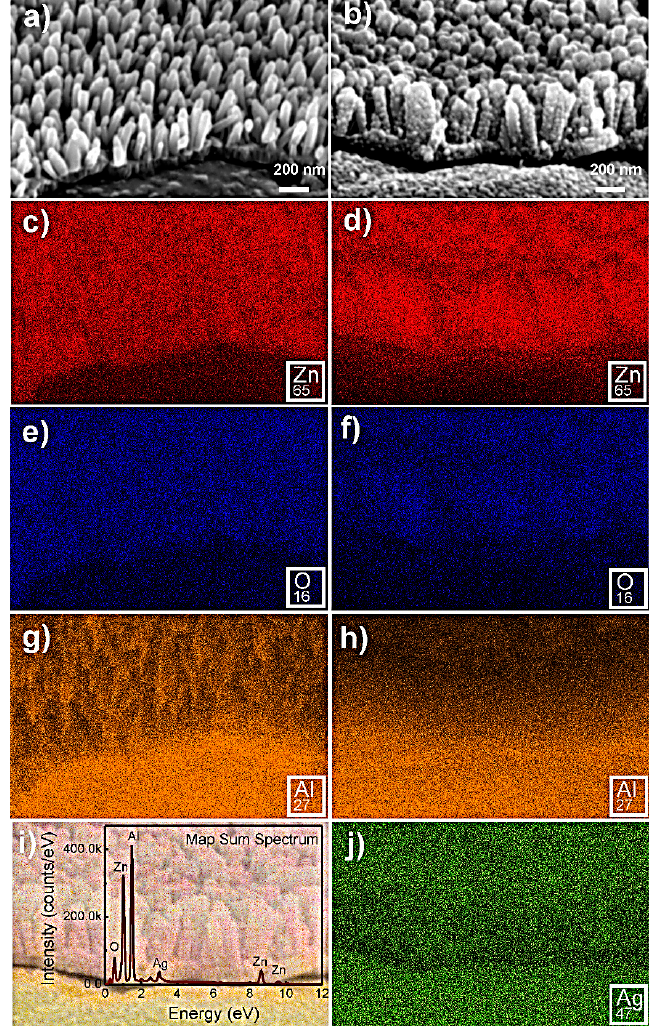
Figure 6. Scanning electron microscopy (SEM) images of ZnO nanorods (NRs) formed at 70 °C with a synthesis time of 5 min ( a ) and ZnO NRs covered with silver nanoparticles (Ag NPs) ( b ). The respective X-ray maps corresponding to Zn are presented in ( c ) and ( d ), O in ( e ) and ( f ), Al in ( g ) and ( h ), and Ag in ( j ). ( i ) Map sum spectrum of the sample with Ag NPs covering the ZnO NRs.